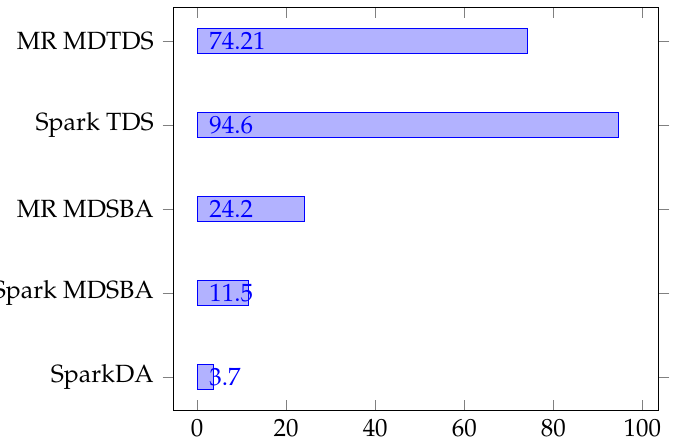
Figure 10. Performance comparison with existing approaches.